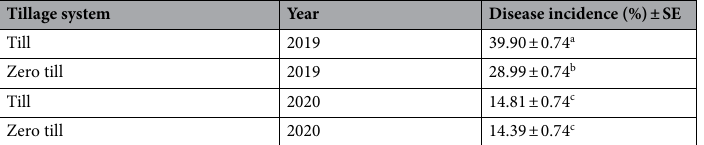
Tillage system Year Disease incidence (%) ±